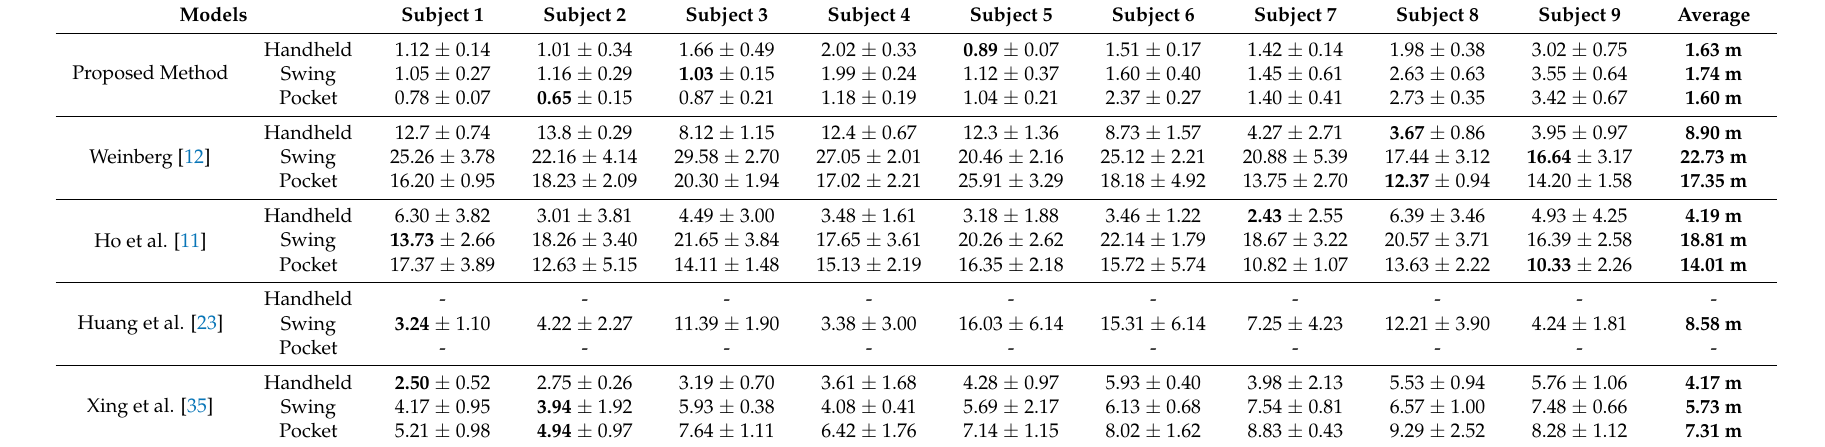
Table 5. Evaluation and Analysis of Traveled Distance Estimation for Indoor